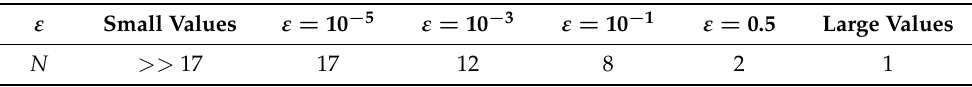
Table 4. The number of iterations for different values of ε using the DE-Sinc integration rule for solving the RO system based on the